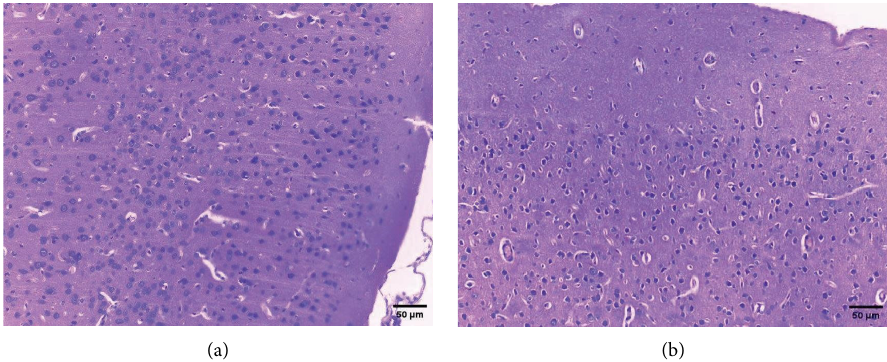
Figure 4: Photomicrograph showing normal rat brain (cerebrum), section (a) taken from rats in group III (1000mg/kg), section (b) taken from rats in group IV (control); H and E stain, 200x magnifcation.